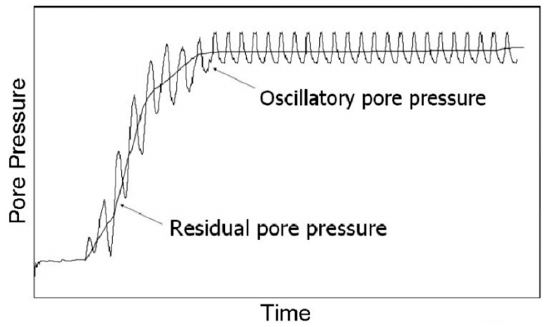
Figure 1. The conceptual sketch of the pore pressure mechanisms (Adapted from Jeng [7]).